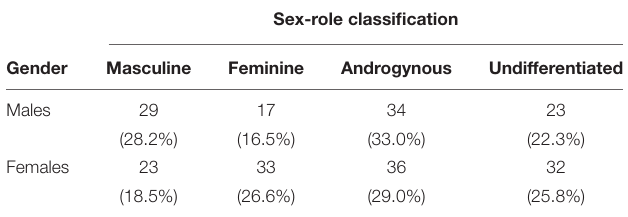
TABLE 1 | Distribution of sex-role categories in sample.